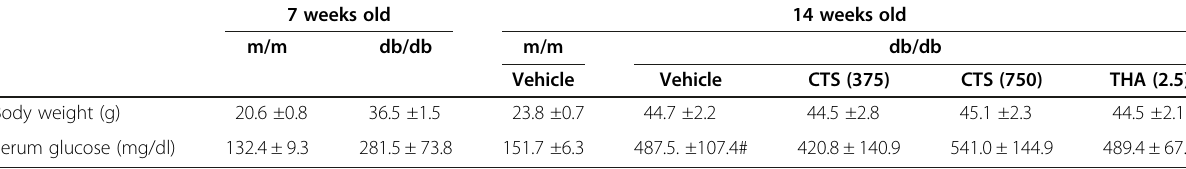
Body weights and serum glucose levels were first measured at the age of 7 weeks old just before starting drug administration. The db/db mice were randomly separated into 4 groups and underwent daily administration of vehicle, 375 mg/kg and 750 mg/kg CTS, or 2.5 mg/kg THA. After completion of the behavioral study, the body weight and serum glucose levels of each animal were again measured at the age of 14 weeks old. CTS and THA represent chotosan extract and tacrine, respectively. Each datum represents the mean ± S.D. (n=6 – 9). ### P <0.001 vs. respective 7w- m/m or 14w- m/m group ( t -test).